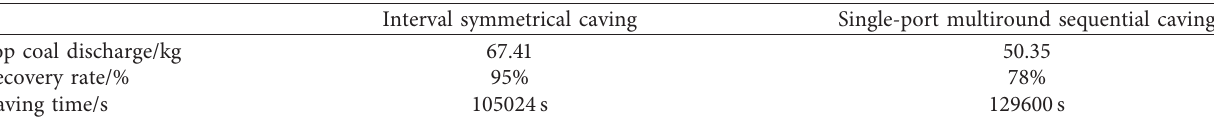
Table 3: Performance of different coal caving methods. Interval symmetrical